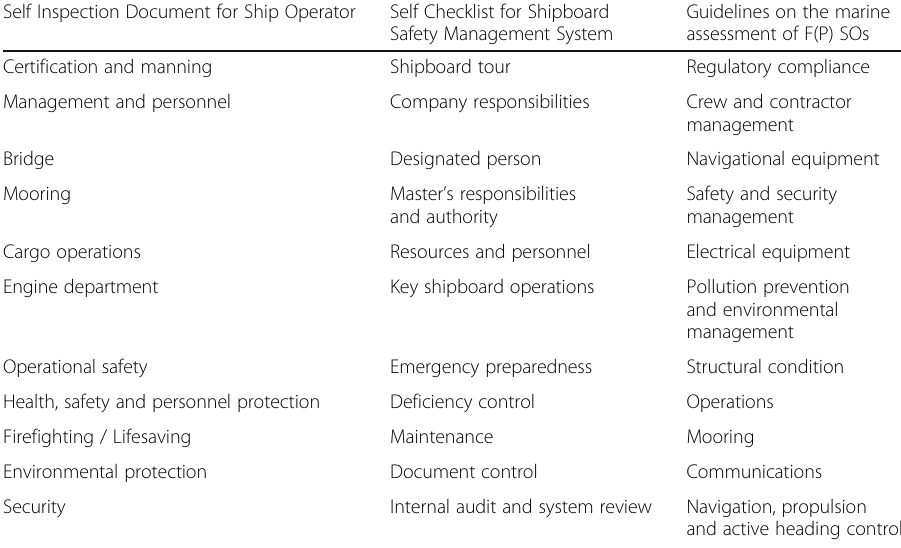
Table 1 Different elements, which can be considered when defining inspection points Self Inspection Document for Ship